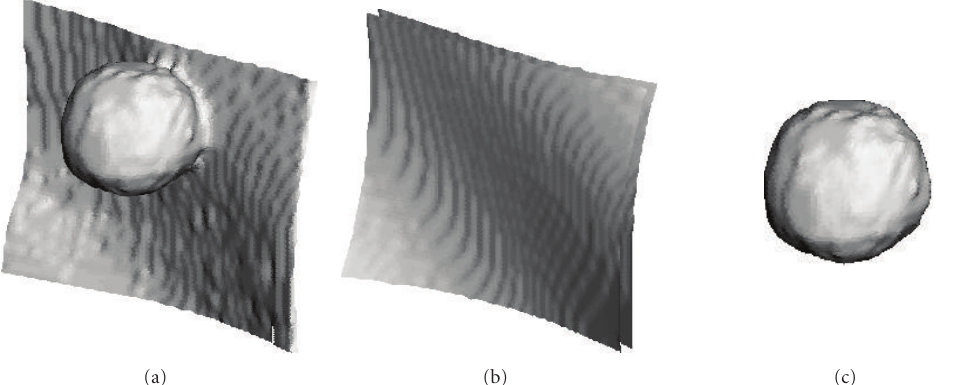
Figure 12: Thoracic wall removal. Light-shaded visualizations of (a) original region of interest, (b) estimated surface function, and (c) nodule after thoracic wall